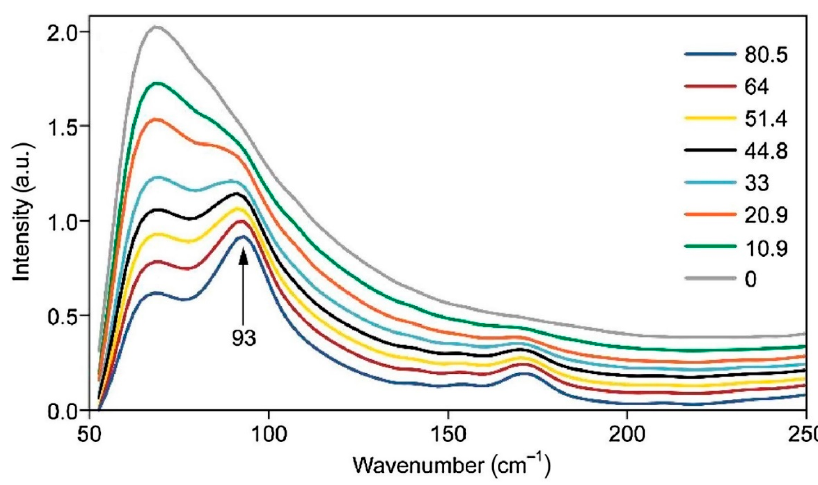
Figure 3. Low frequency Raman spectra of calibration set samples, calculated crystallinities of the samples are listed on the left hand side in the Figure. Reproduced with permission from Ref. [24].